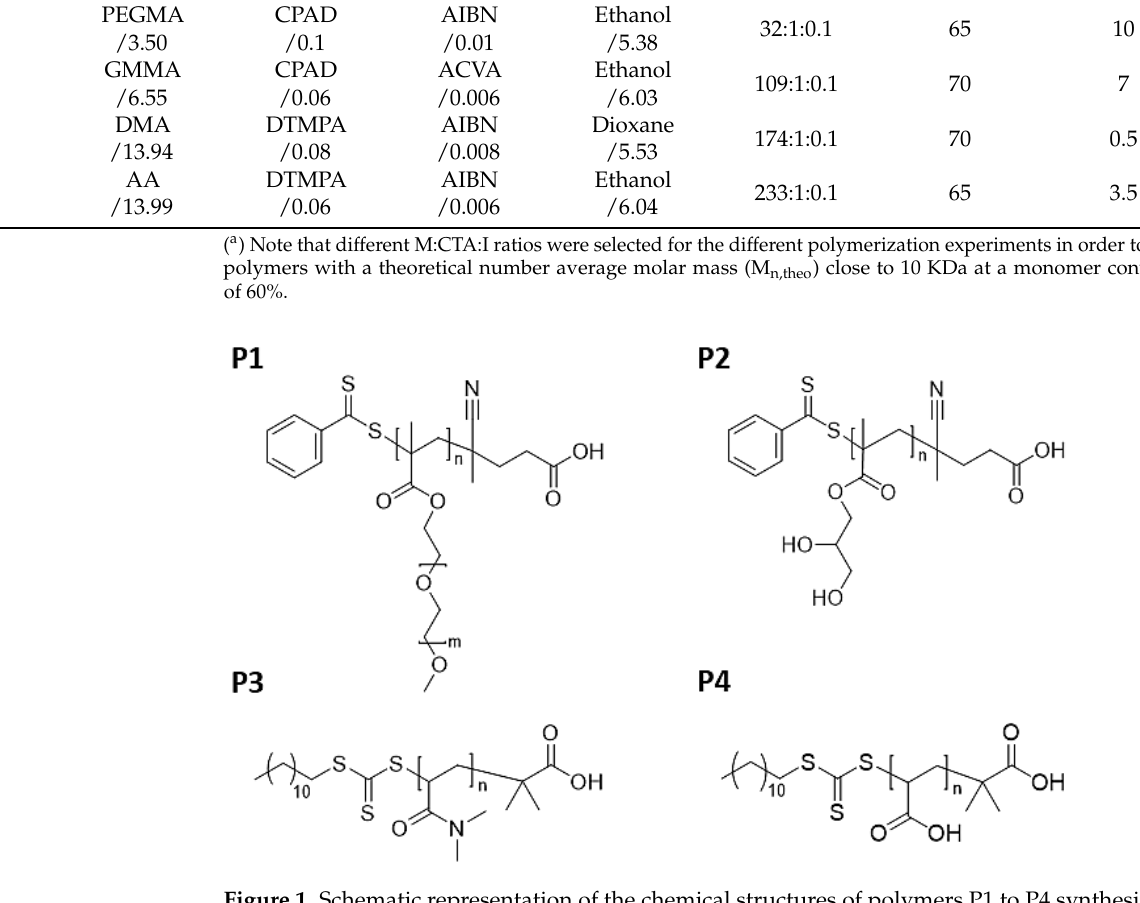
Figure 1. Schematic representation of the chemical structures of polymers P1 to P4 synthesized by RAFT polymerization. Table 2. Dialysis conditions and physicochemical characterization of polymers P1-P4.